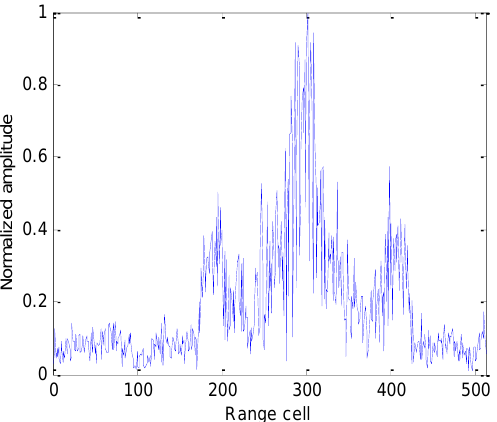
Figure 8. The 128th pulse’s range compression via Discrete Fourier transform (DFT).